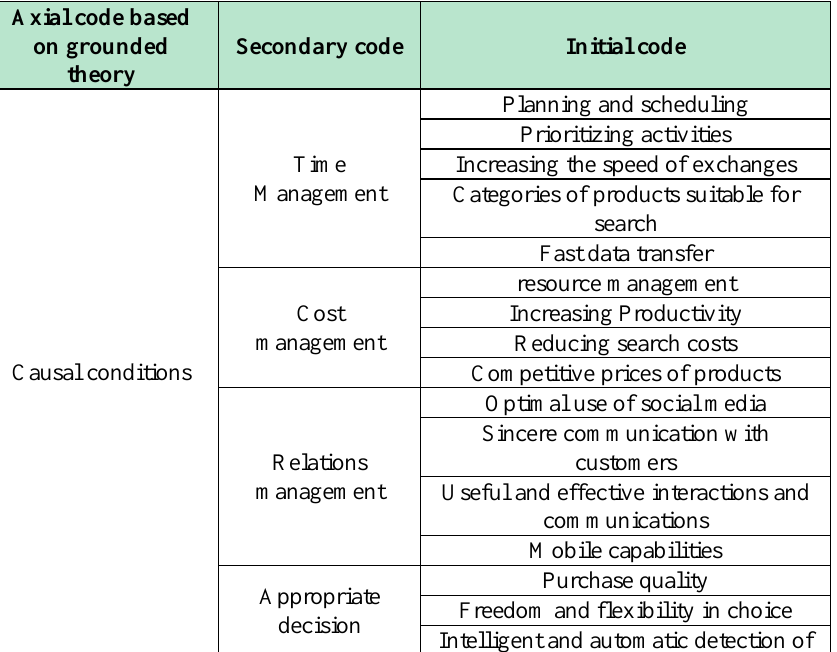
Table 1: Open coding of qualitative data (causal